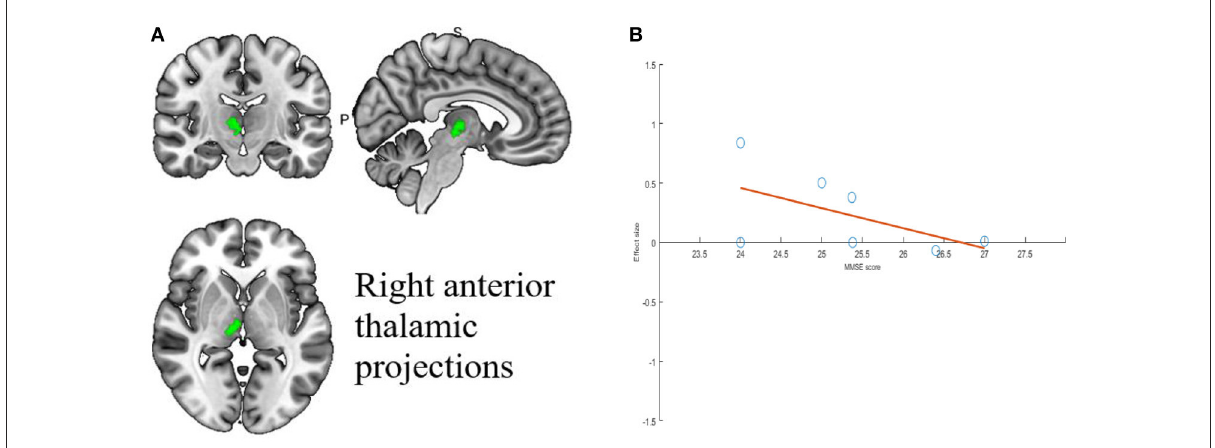
FIGURE5 Results of Meta-regression linear model analysis. (A) MMSE scores of MCI patients are negatively correlated with regional activity in Right anterior thalamic projections. (B) The effect sizes needed to create this plot were extracted from the peak voxels of the maximum slope difference. All studies are indicated by the empty blue circles. Regression lines (Meta-regression SDM slopes) are shown as straight